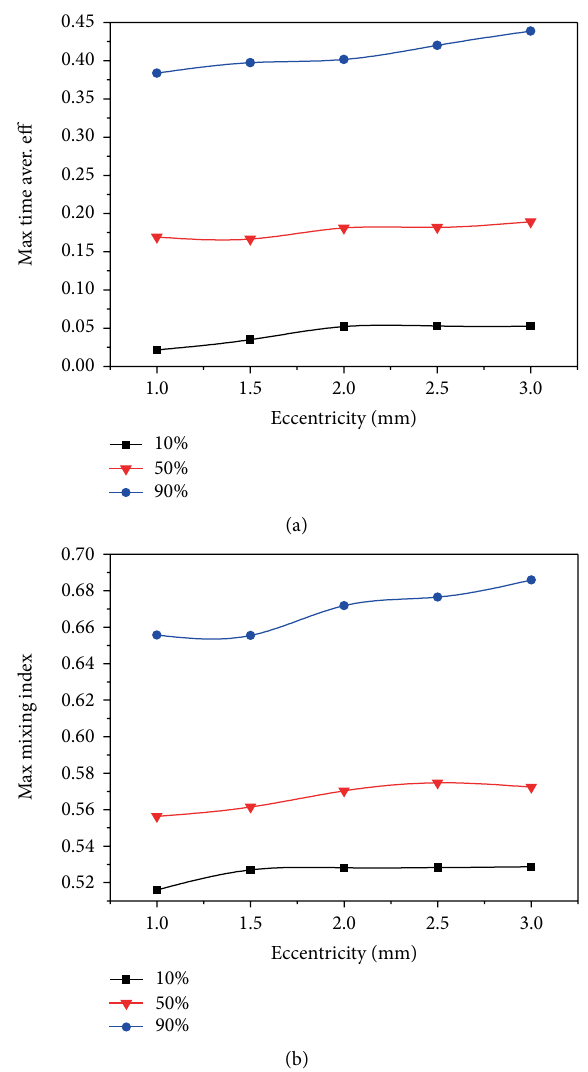
Figure 17: Influence of eccentricity on the maximum time averaged efficiency (a) and mixing index